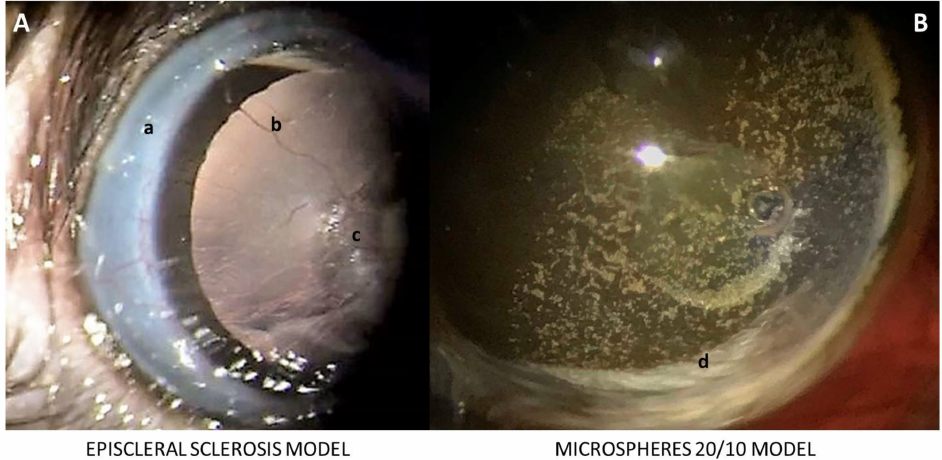
Figure 2. Ocular surface of rat eye in ocular hypertensive models. ( A ) Episcleral sclerosis model. a: sclerosis of episcleral veins; b: corneal neovascularization; c: corneal leucoma. ( B ) Microsphere 20/10 model. d: microspheres of poly lactic-co-glycolic acid (PLGA) in the anterior chamber of the rat